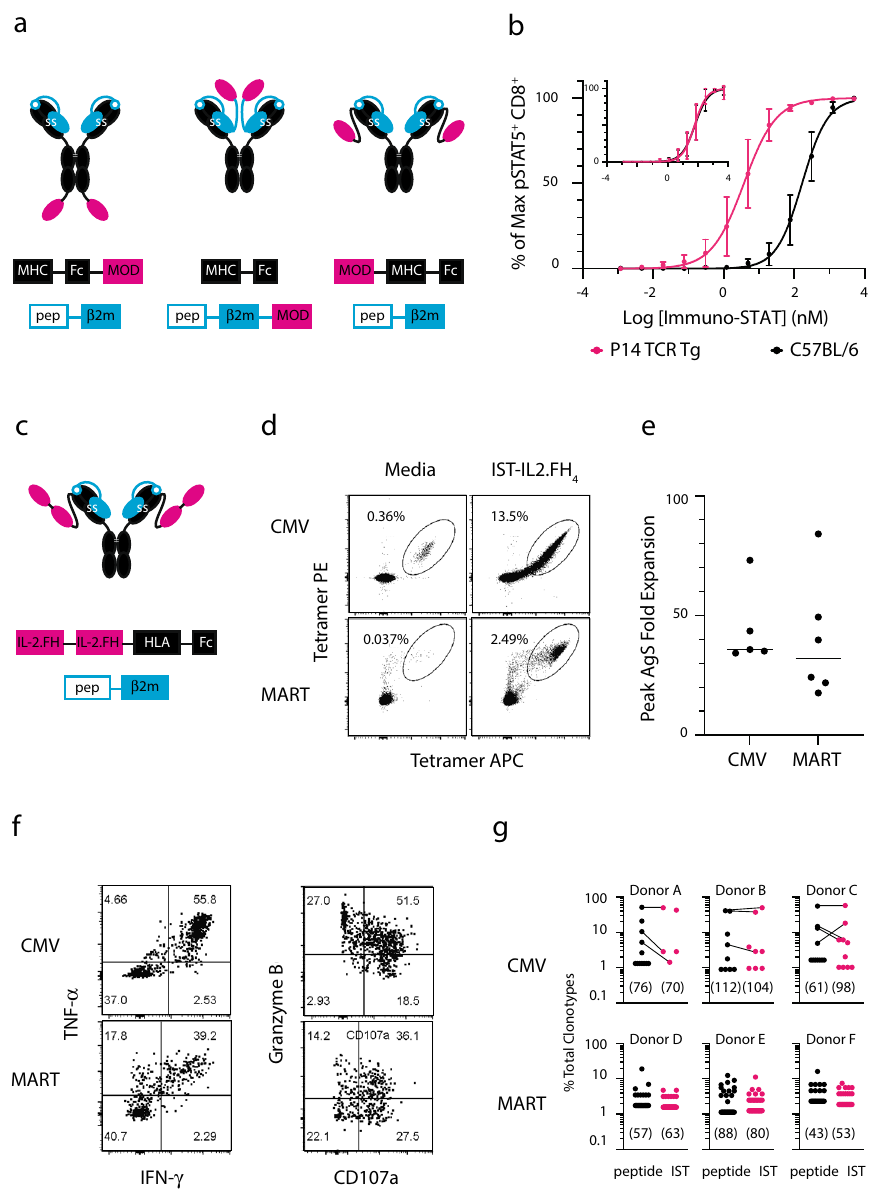
Figure 1. Immuno-STAT design, optimization and activity. ( a ) Immuno-STAT frameworks comprising peptide (pep) epitope, β2m, MHC heavy chain, Fc, and co-modulatory domain (MOD) in different relative positions, covalently linked by engineered (ss) and native ( =) disulfide bonds. ( b ) In vitro pSTAT5 activity of P14 transgenic versus C57BL/6 CD8 splenocytes challenged with construct LCMV-IST-IL2.FH 4 . Inset: Fc fusion bearing four IL2.FH but without pMHC. %pSTAT5 + responses within each independent dose response titration were normalized as: normalized response = (sample − minimum)/(maximum − minimum). Data represent mean ± SD of duplicate samples from three independent experiments. ( c ) Humanized Immuno-STAT framework comprising two copies of pHLA, four copies of IL2.FH and human IgG1 Fc. ( d ) Representative dual-tetramer plots of human PBMC stimulated in vitro for ten days with media, CMV-IST-IL2.FH 4 , or MART-IST-IL2.FH 4 . ( e ) Peak fold expansion of AgS T cells from human PBMC incubated with CMV-IST-IL2.FH 4 (n = 5 donors) and IST-MART-IL2.FH 4 (n = 6 donors), from 1 to 4 independent expansions per donor. ( f ) Representative IFN-γ, TNF-α, CD107a, and granzyme B staining following cognate peptide challenge of Immuno-STAT-expanded CMV- or MART-specific T cells. ( g ) Paired TCRαβ sequence frequencies from individual CMV- or MART- specific CD8 T cells expanded with cognate Immuno-STAT or peptide. Lines connect Immuno-STAT- and peptide-expanded clones having TCRαβ sequence identity. Three donors per specificity. Total clones surveyed in